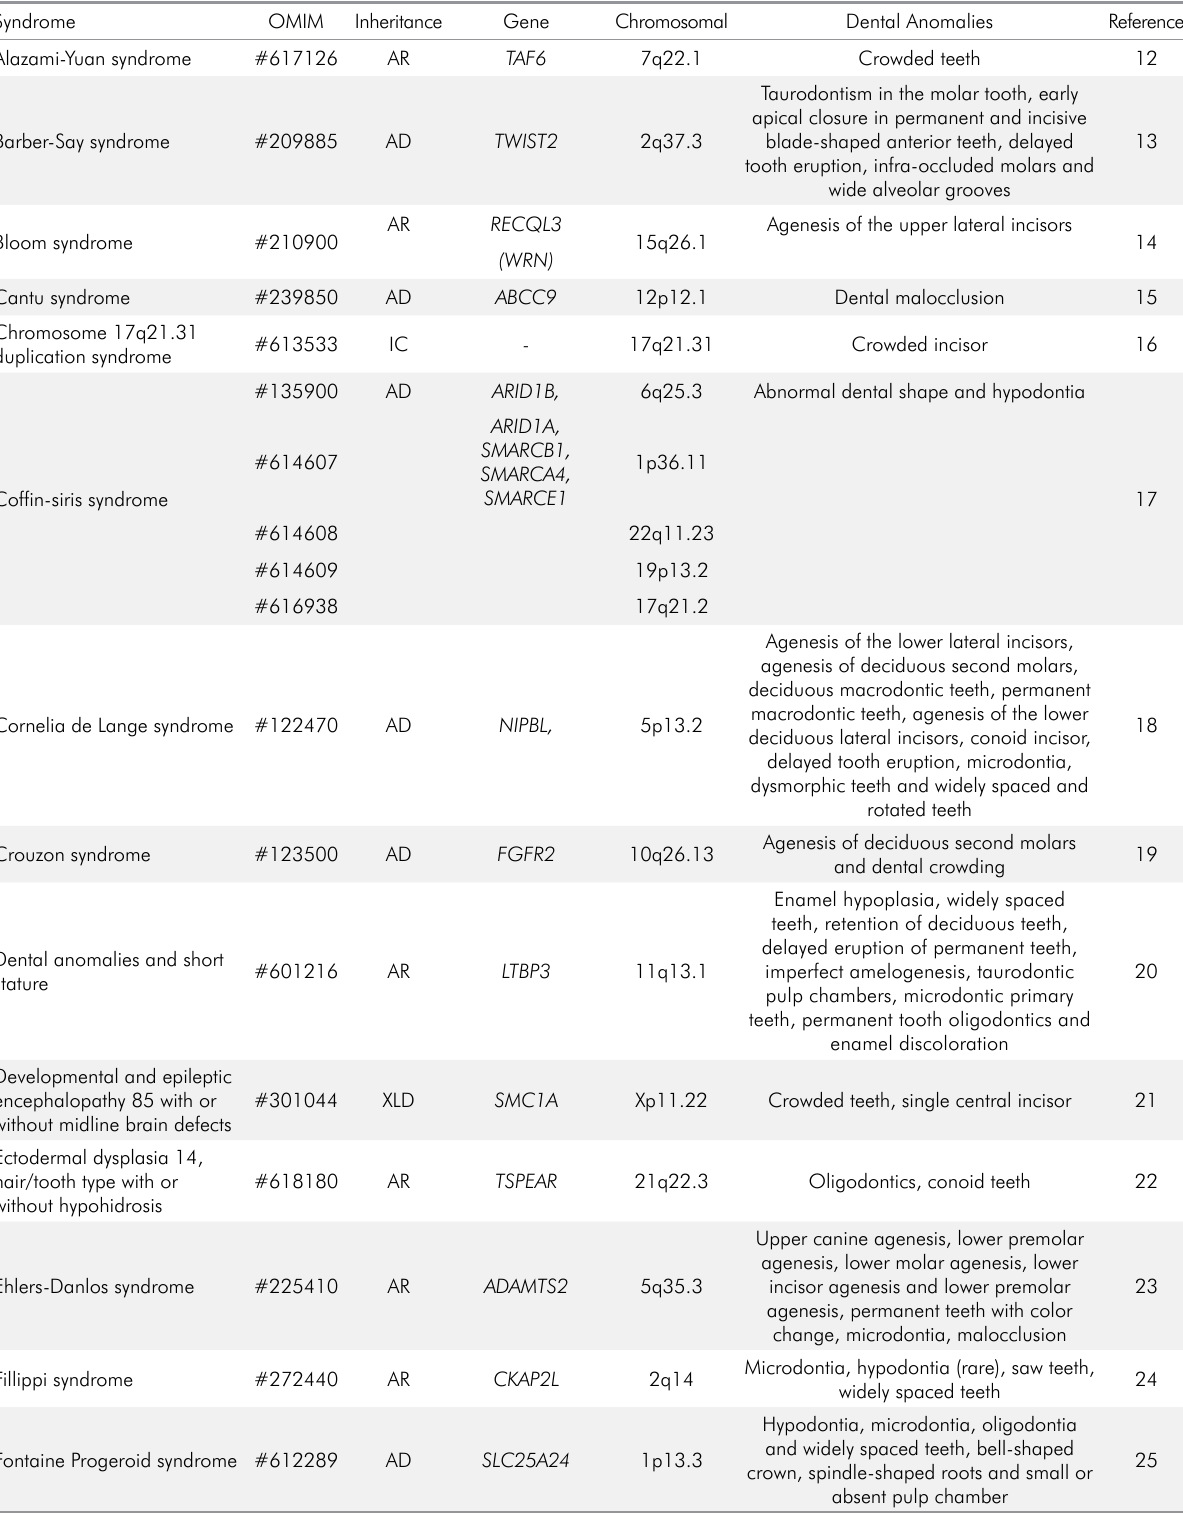
Table 1. Syndromes with hypertrichosis and dental